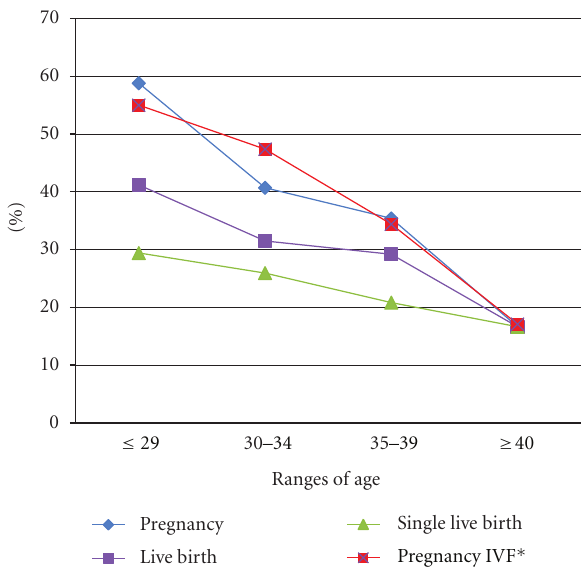
Figure 2: Rates of primary outcomes: pregnancy, live birth, and singleton live birth from INVO procedure. ∗ From the US Centers for Disease Control and Prevention (CDC), 2009 National Summary Report. P > 0 . 05 for pregnancy rates between traditional IVF versus INVO ( T -test). For INVO results, live birth and single live birth rates include up to date ongoing